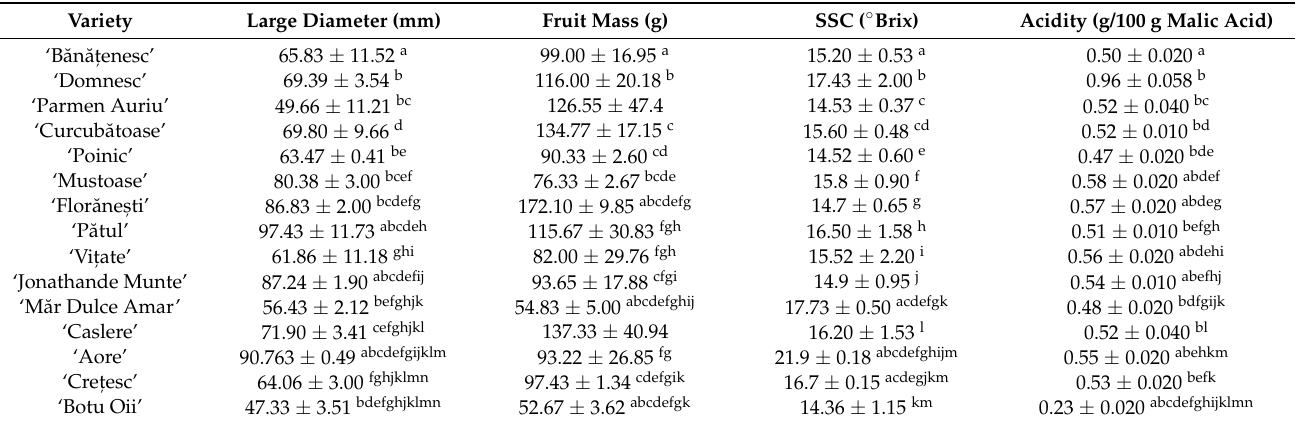
Table 4. The characteristics of the apple varieties before grafting.